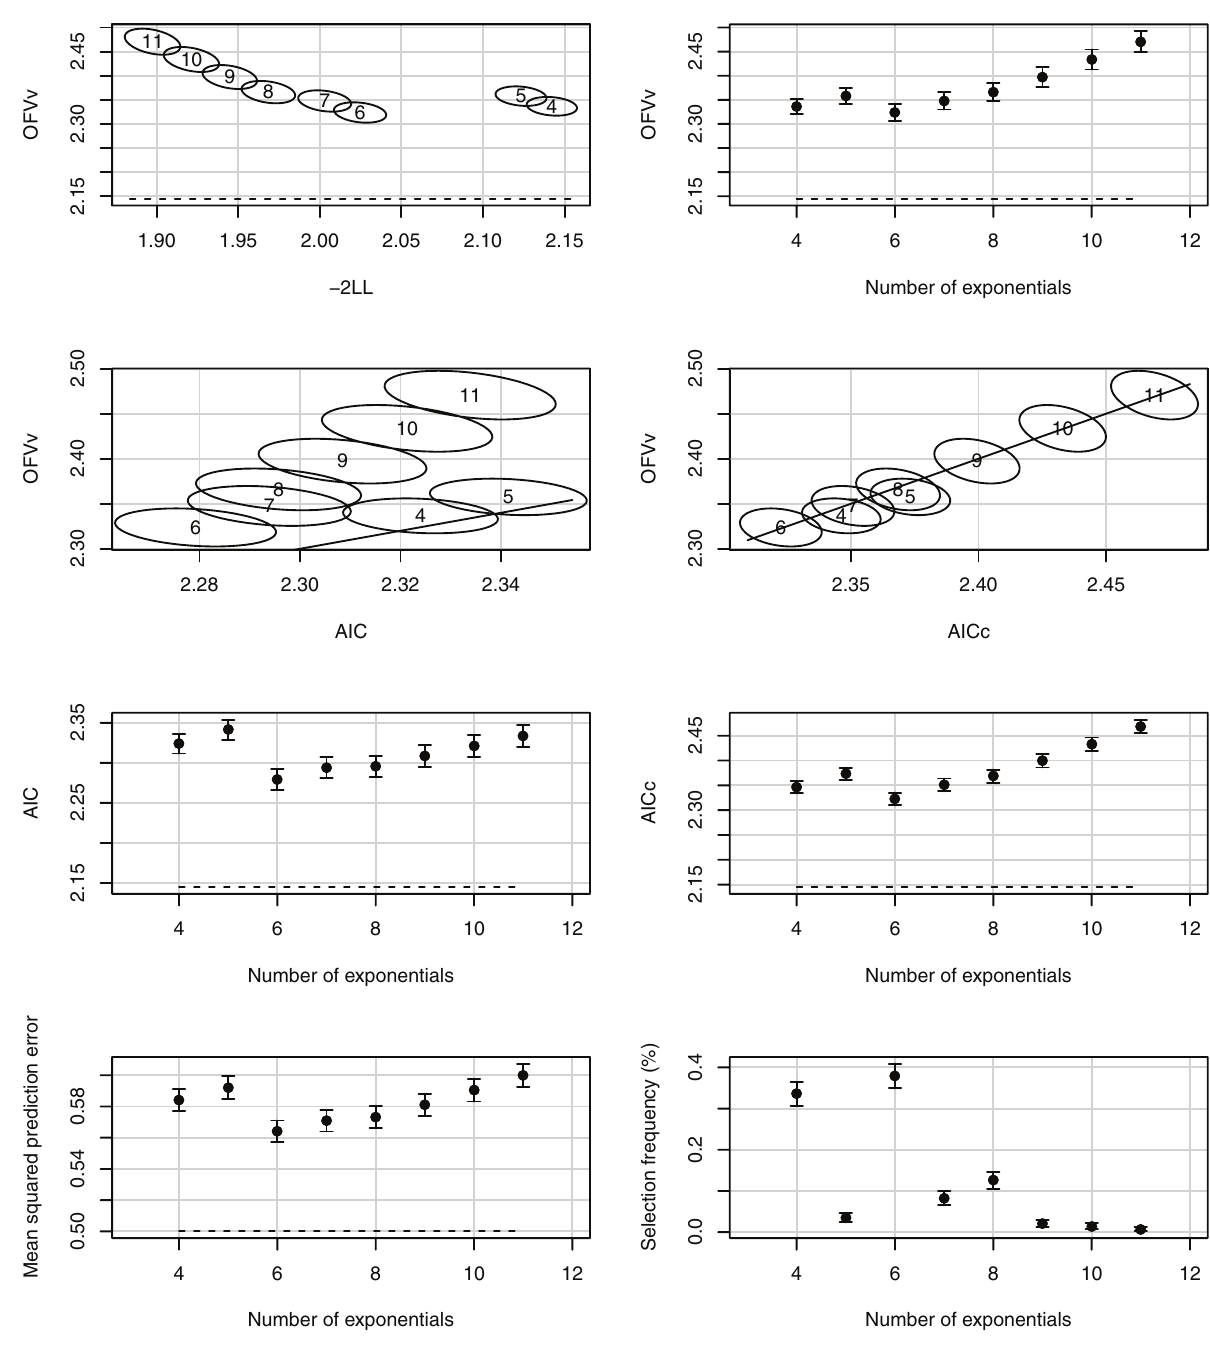
Figure 3. Mean OFV as a function minus of two log likelihood (-2LL), the number of exponentials, AIC and AIC v AIC , prediction error ν 2 , and model selection frequencies as a function of the number of exponentials (lower four panels), averaged over c 1000 runs, N = 5, M = 11, σ 2 = 0.5, ω 2 = 0. The dashed lines represent the theoretical values for an infinite amount of data (see Supplementary material). Error bars and ellipses denote 95% confidence intervals and confidence regions, respectively. The numbers in the confidence regions denote the number of exponentials. The solid lines in the middle upper panels are lines of